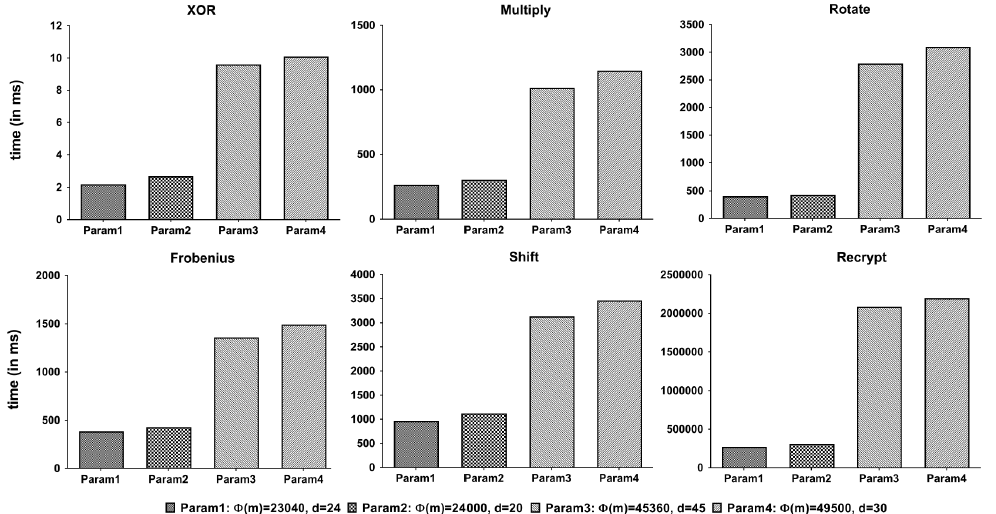
Figure 12. Execution times of unit operations.